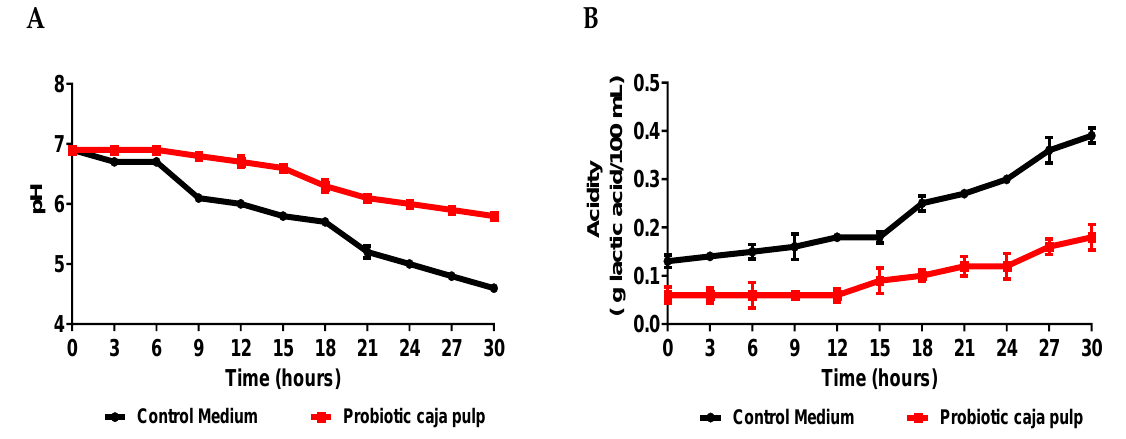
Figure 2. Time course of Bifidobacterium animalis ssp. lactis B94 fermentation in caja pulp and the control medium. ( A ) pH; ( B ) Acidity.